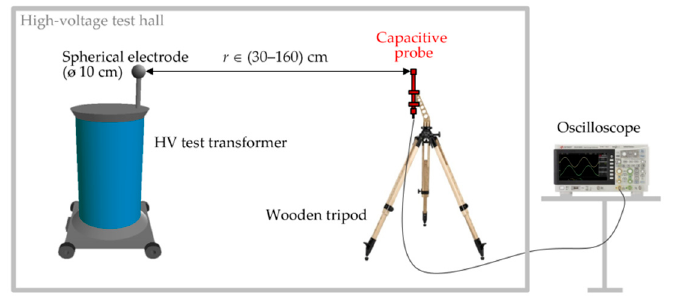
Figure 12. Measurement setup for determining the dependence of the signal amplitude received by the capacitive probe on the distance r from the signal source (spherical HV electrode).